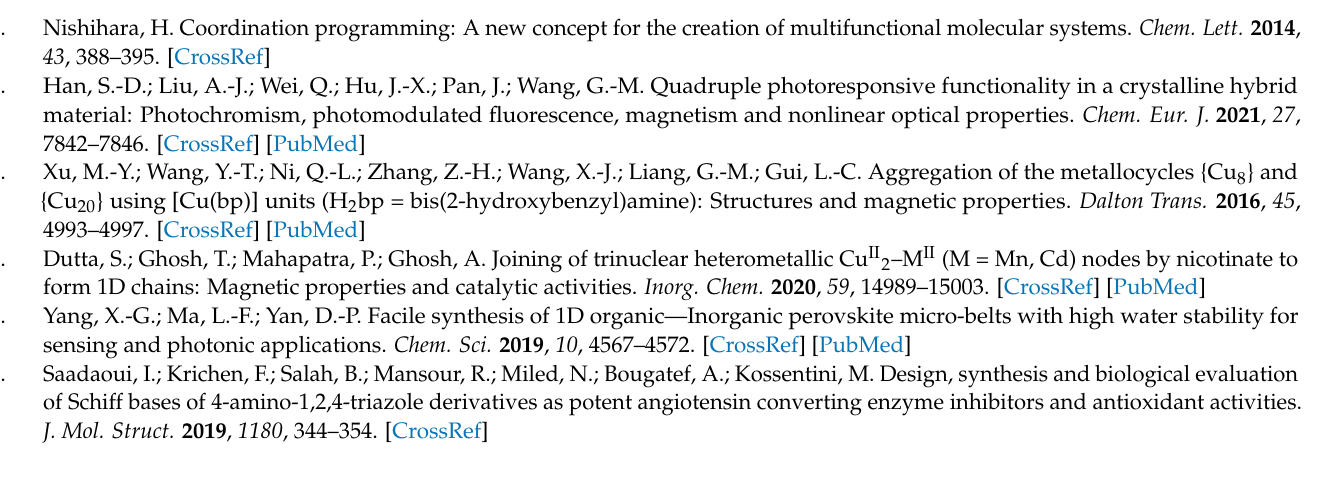
Figure S2: Simulated and experimental PXRD pattern of 1 placed in the air for more than 14